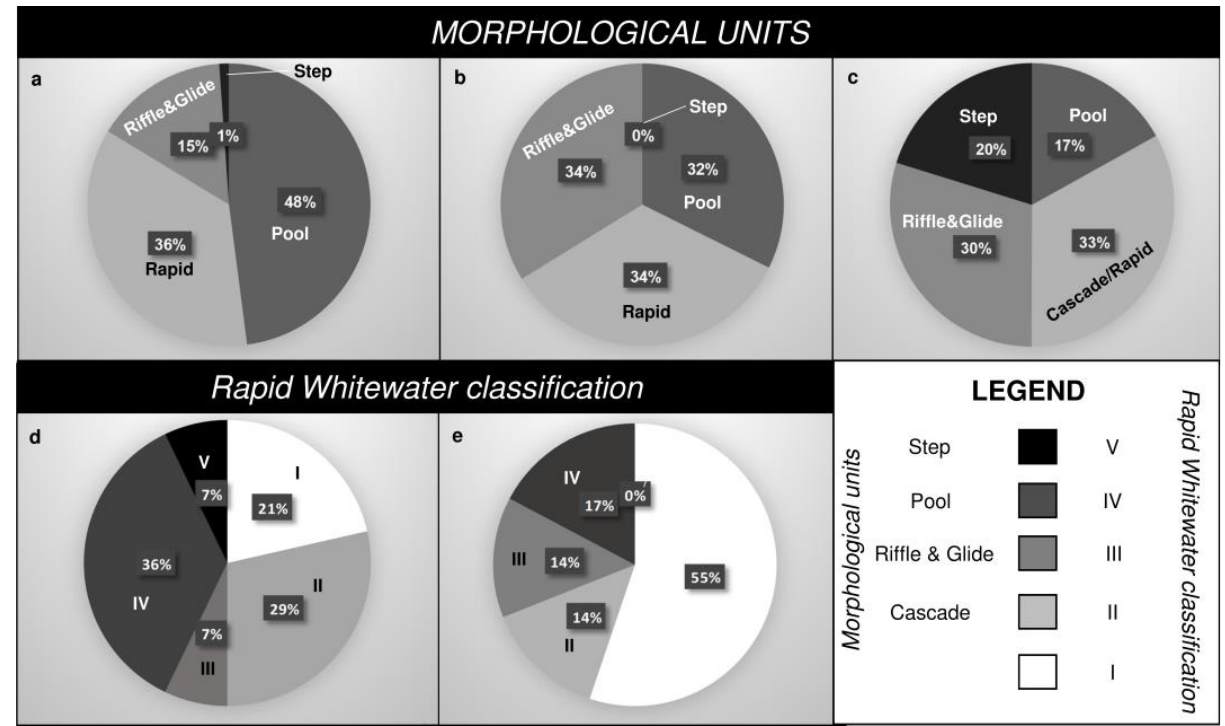
Figure 7. Graphs of the percentage of the different morphological units ( a – c ) and of the classification of rapids according to the Whitewater system (AMC, 2008) ( d , e ) along the investigated segments GS—Gole del Sesia—and CS—Classico del Sesia. For Canyoning Sorba (CNS), the White-Water classification is not applicable and the classification for canyoning is reported according to Vertical and Aquatic Characters and Commitment only in Supplementary S1.